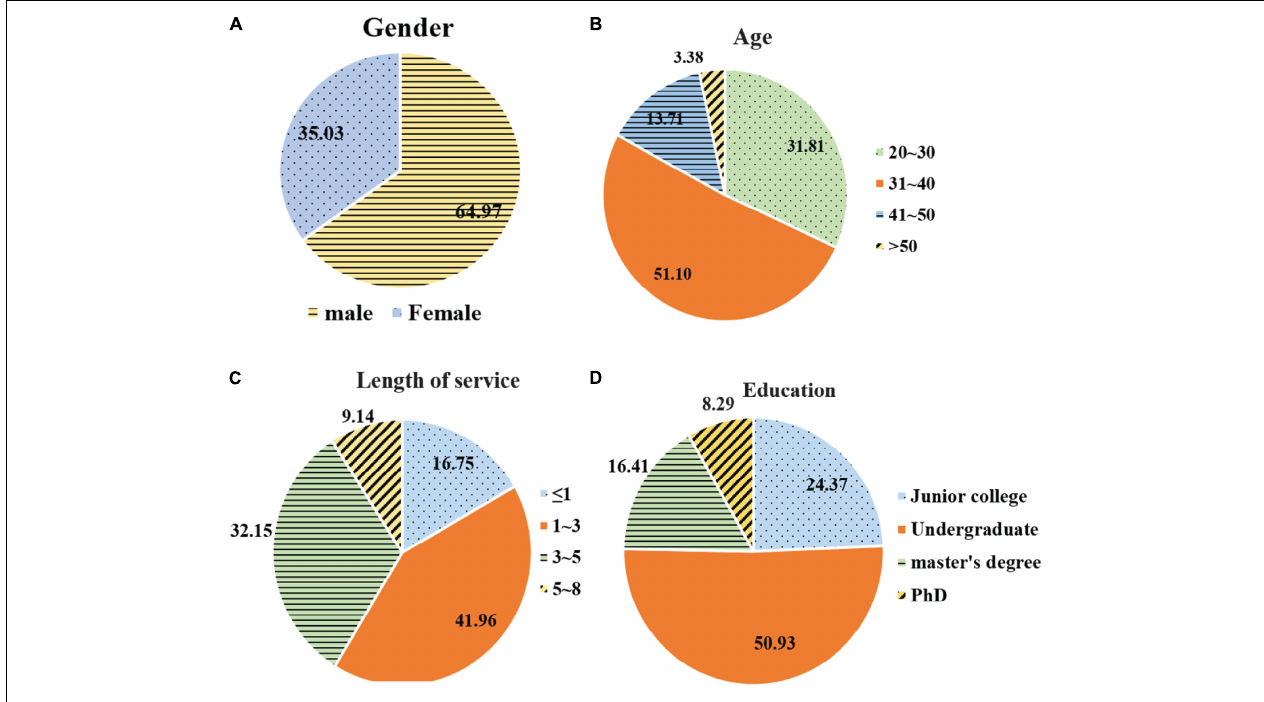
FIGURE 2 | Basic characteristics of individuals. (A) Sex ratio; (B) Age distribution; (C) Seniority distribution; (D) Educational